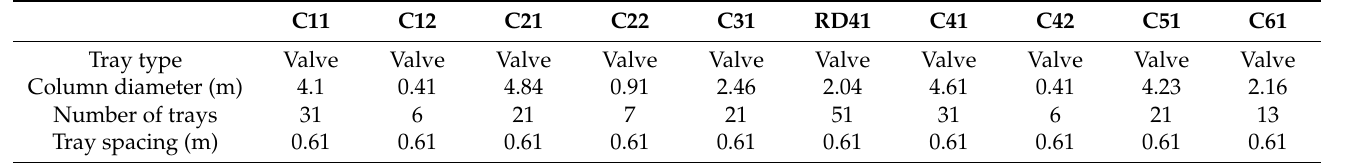
Table 2. Design parameters of all distillation